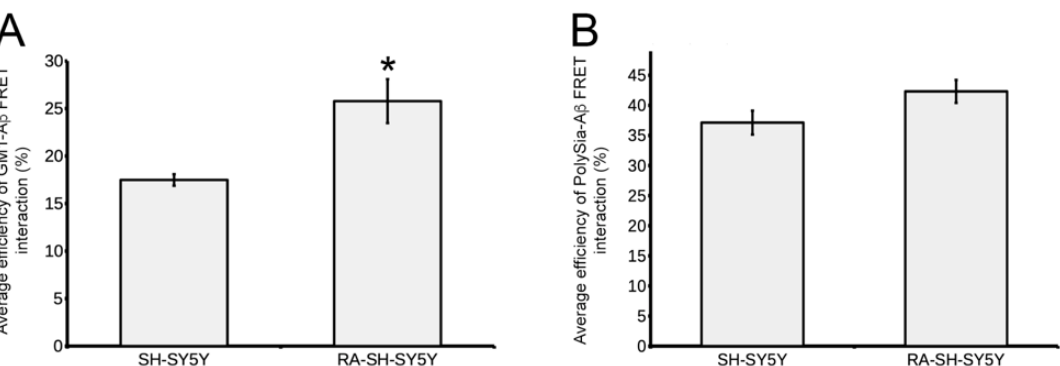
Figure 5. Comparative analysis of FRET interactions. Efficiency of FRET interactions between the fluorochrome Alexa Fluor 488 on GM1 ( A ) and PolySia ( B ) with Alexa Fluor 568 on A β -42 species adhering to the plasma membrane of SH-SY5Y and RA-SH-SY5Y cells after 1 h of seeding. Values are expressed as average ± SE; n = 3. T-test * p < 0.05 vs.